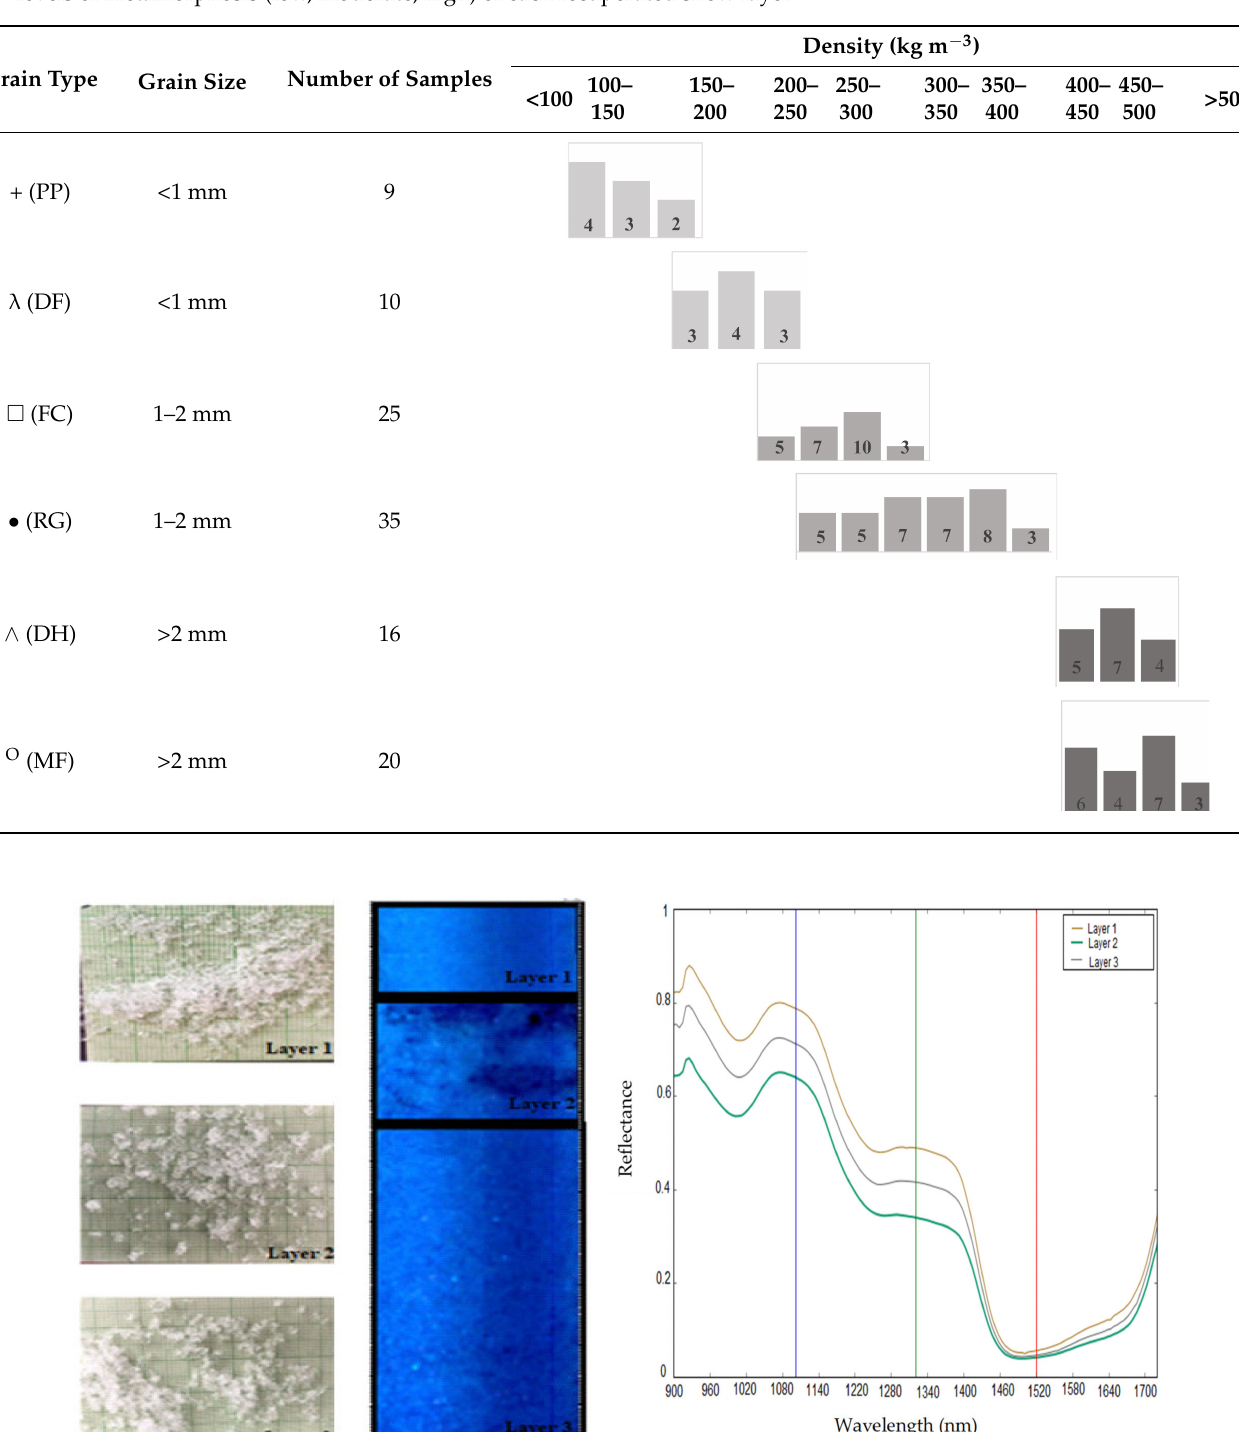
Table 3. Distribution of snow density in terms of type and size of snow grains (field data: 2018, 2019 and 2020), with their corresponding symbols. PP—precipitation particles; DF—decomposing and fragmented precipitation particles; RG— rounded grains; FC—faceted crystals; DH—depth hoar (goblets); MF—melt forms. The different shades of gray show the levels of metamorphosis (low, moderate, high) of each recuperated snow layer.